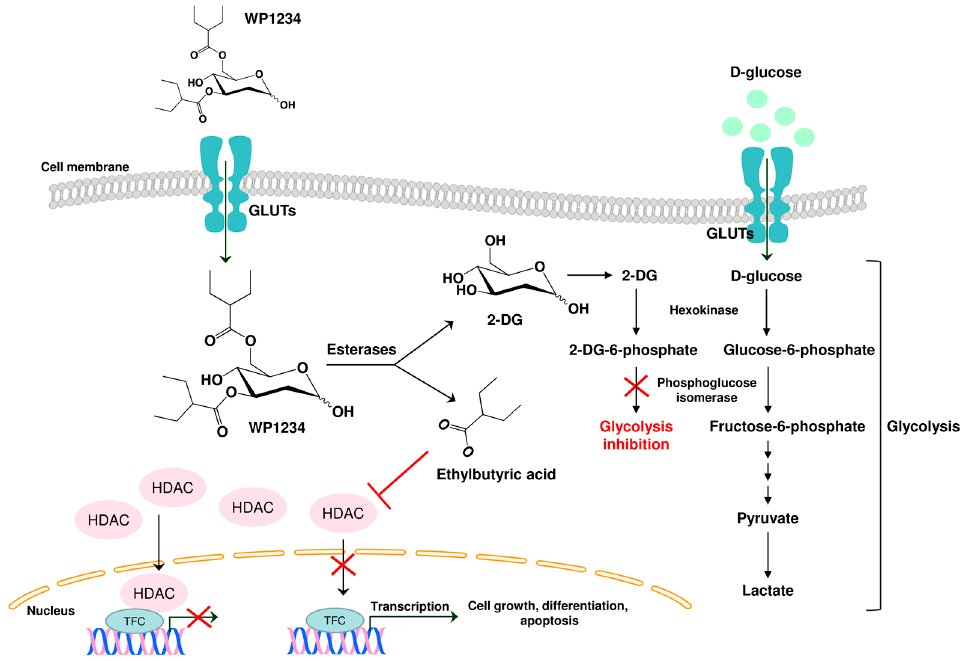
Figure 13. Schematic illustration of WP1234 intracellular mechanism of action. WP1234 undergoes enzymatic cleavage via esterases releasing 2-DG (2-deoxy-D-glucose) and ethylbutyric acid. 2-DG is phosphorylated via hexokinase to 2-deoxy-D-glucose-6-phosphate that could not be further converted via phosphoglucose isomerase. Consequently, the glycolysis process is inhibited. On the other hand, ethylbutyric acid acts as an HDCA inhibitor, allowing the transcription of several genes coding proteins engaged in cell growth, differentiation, and apoptosis; GLUT—glucose transporters, TCF—transcription factors complex, HDAC—histone deacetylase.